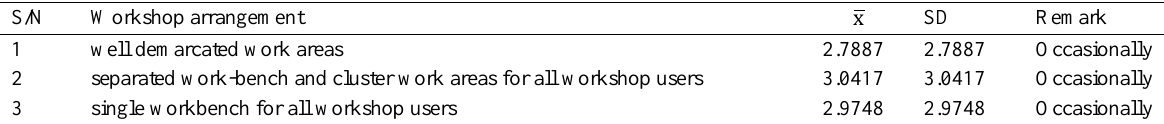
Table 3: Mean Score of Accident Rates in Different Electrical/Electronic Workshops having Different Workshop